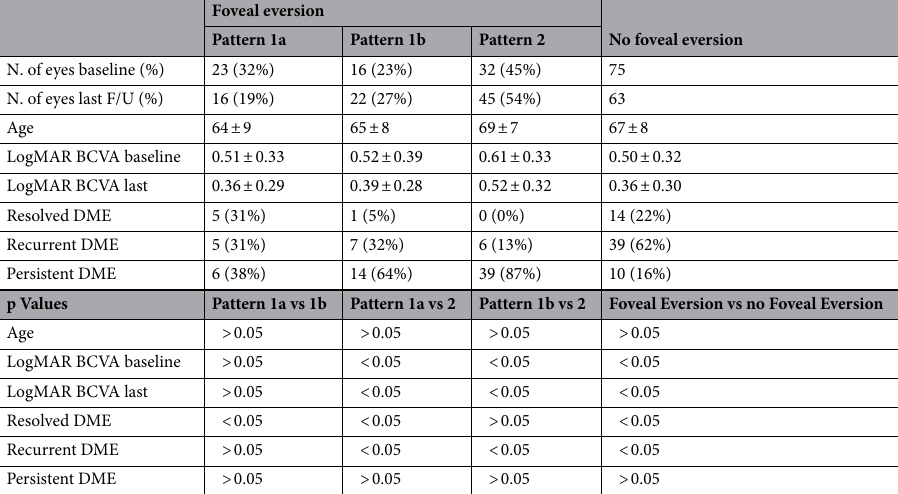
Table 2. Foveal eversion sub-analysis in DME eyes and clinical parameters. DME eyes are divided accordingly with the presence and type of foveal eversion, independently from the treatments. BCVA best corrected visual acuity, DME diabetic macular